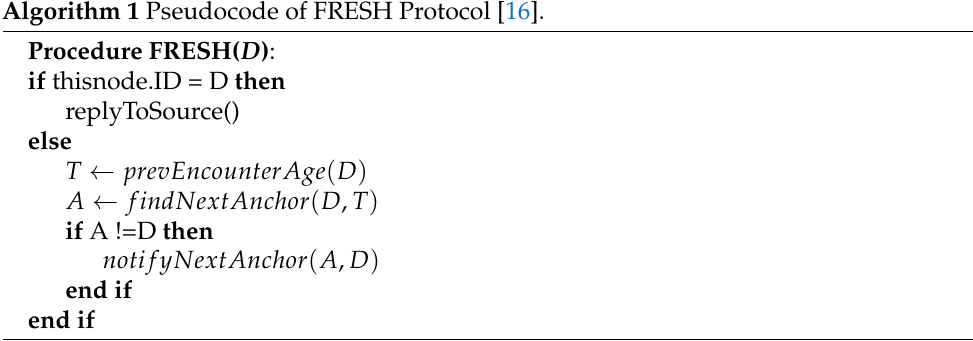
Algorithm 1 Pseudocode of FRESH Protocol